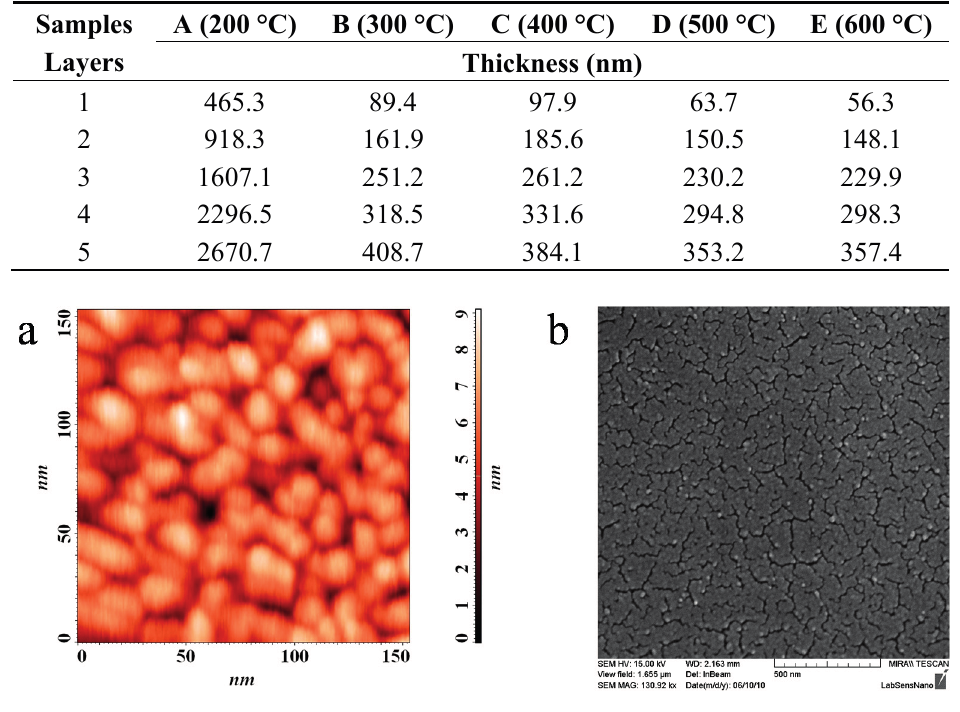
Figure 2. AFM ( a ) and SEM ( b ) scans of the printed layer surface.